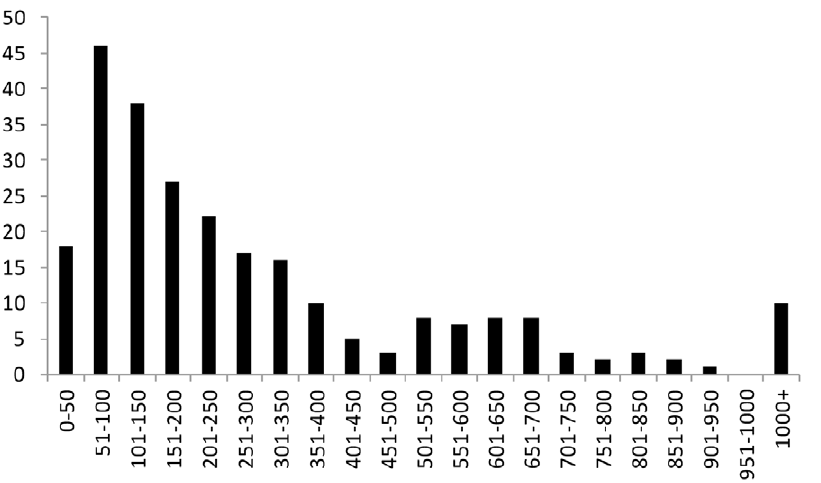
Figure 7. Distribution of the number of words used in species descriptions. This histogram show the number of species that have original descriptions of a given length divided into increments of 50. Note that the majority of species are described by less that 500